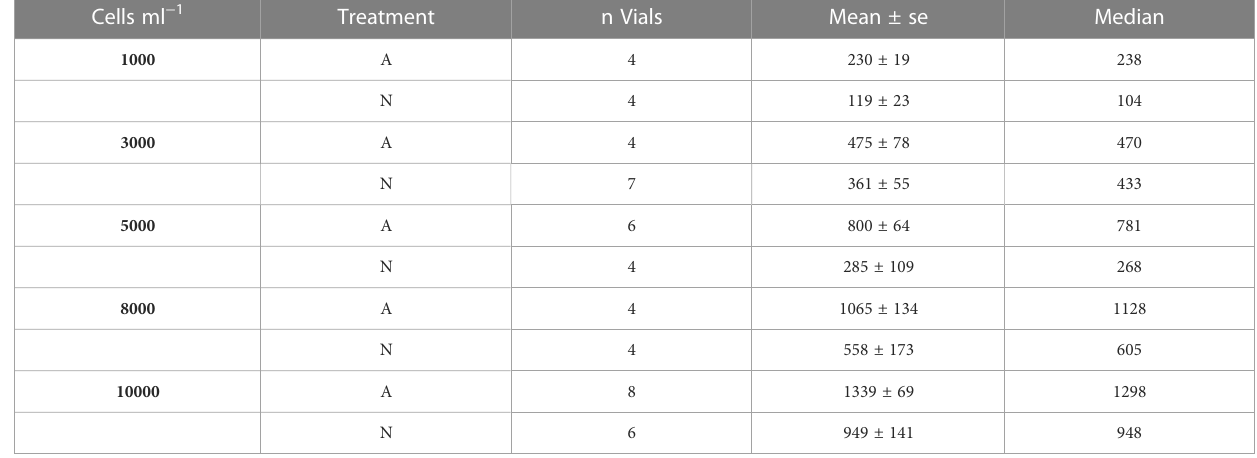
TABLE 3 Overview descriptive statistics of the calculated ingestion rates (cells copepod − 1 h − 1 ) after Frost (1972).